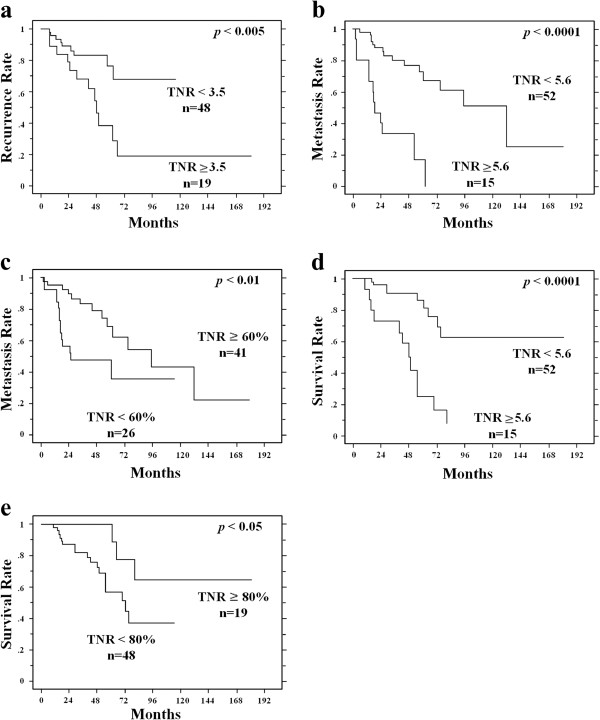
The results of a univariate analysis using the Kaplan-Meier method. a. The five-year local recurrence rates demonstrated a significant difference between the two groups divided by the TNR following treatment (the cut-off value was 3.5, p < 0.005). b. The five-year metastasis rates demonstrated a significant difference between the two groups divided by the TNR prior to treatment (the cut-off value was 5.6, p < 0.0001). c. The five-year metastasis rates demonstrated a significant difference between the two groups divided by the residual ratio of the TNR (the cut-off value was 60%, p < 0.01). d. The five-year disease-specific survival rates demonstrated a significant difference between the two groups divided by the TNR prior to treatment (the cut-off value was 5.6, p < 0.0001). e. The five-year disease-specific survival rates demonstrated a significant difference between the two groups divided by the residual ratio of the TNR (the cut-off value was 80%, p < 0.05).